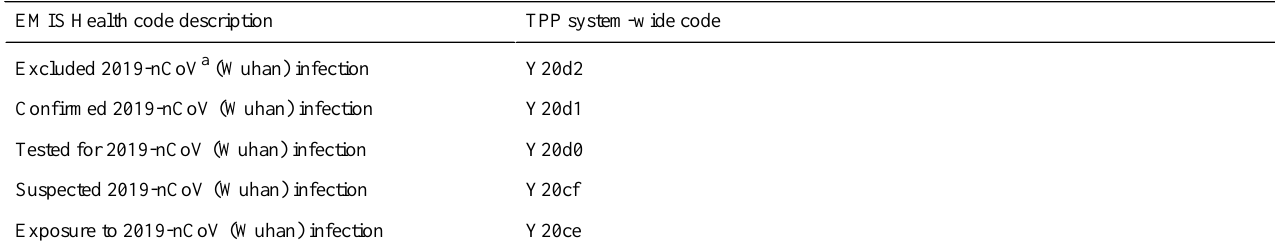
Table 4. Local EMIS Health namespace descriptions and TPP system-wide codes for COVID-19.